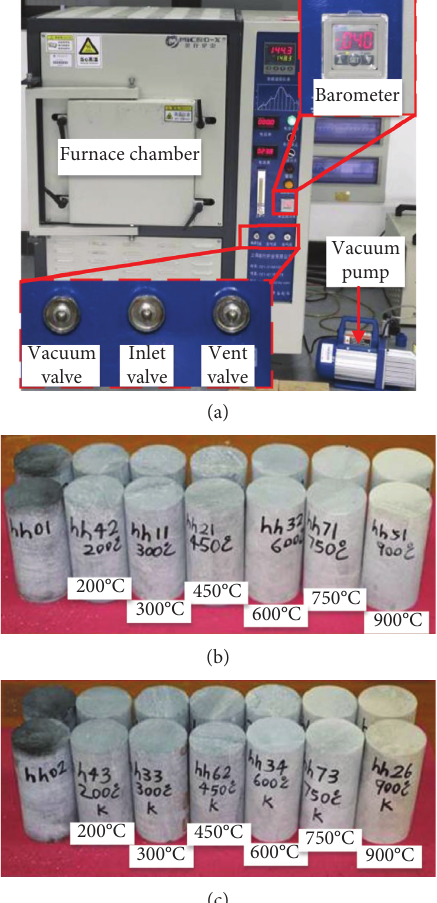
Figure 3: (a) MXQ1700 box-type furnace, and the heating methods and limestone specimens after heat treatment under (b) V and (c) A conditions,